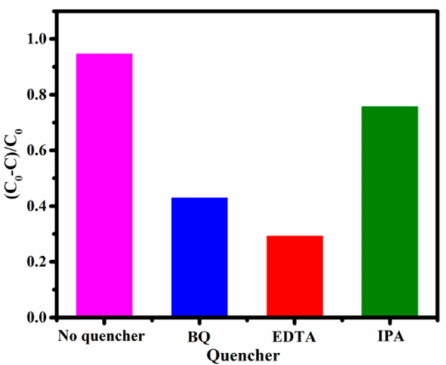
Figure 8. The trapping tests of active species during the photocatalytic degradation of MO over BTTC-120 under visible